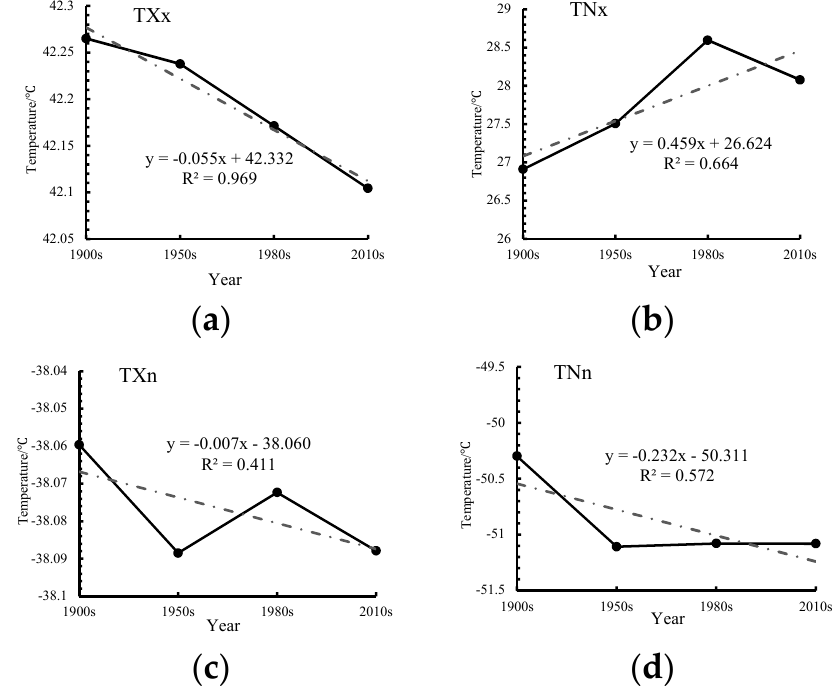
Figure 6. Inter-annual variations in indexes of annual extreme temperature events in Heilongjiang Province between the 1900s and 2010s. ( a ) Maximum value of daily maximum temperature; ( b ) Maximum value of daily minimum temperature; ( c ) Minimum value of daily maximum temperature; ( d ) Minimum value of daily minimum temperature.